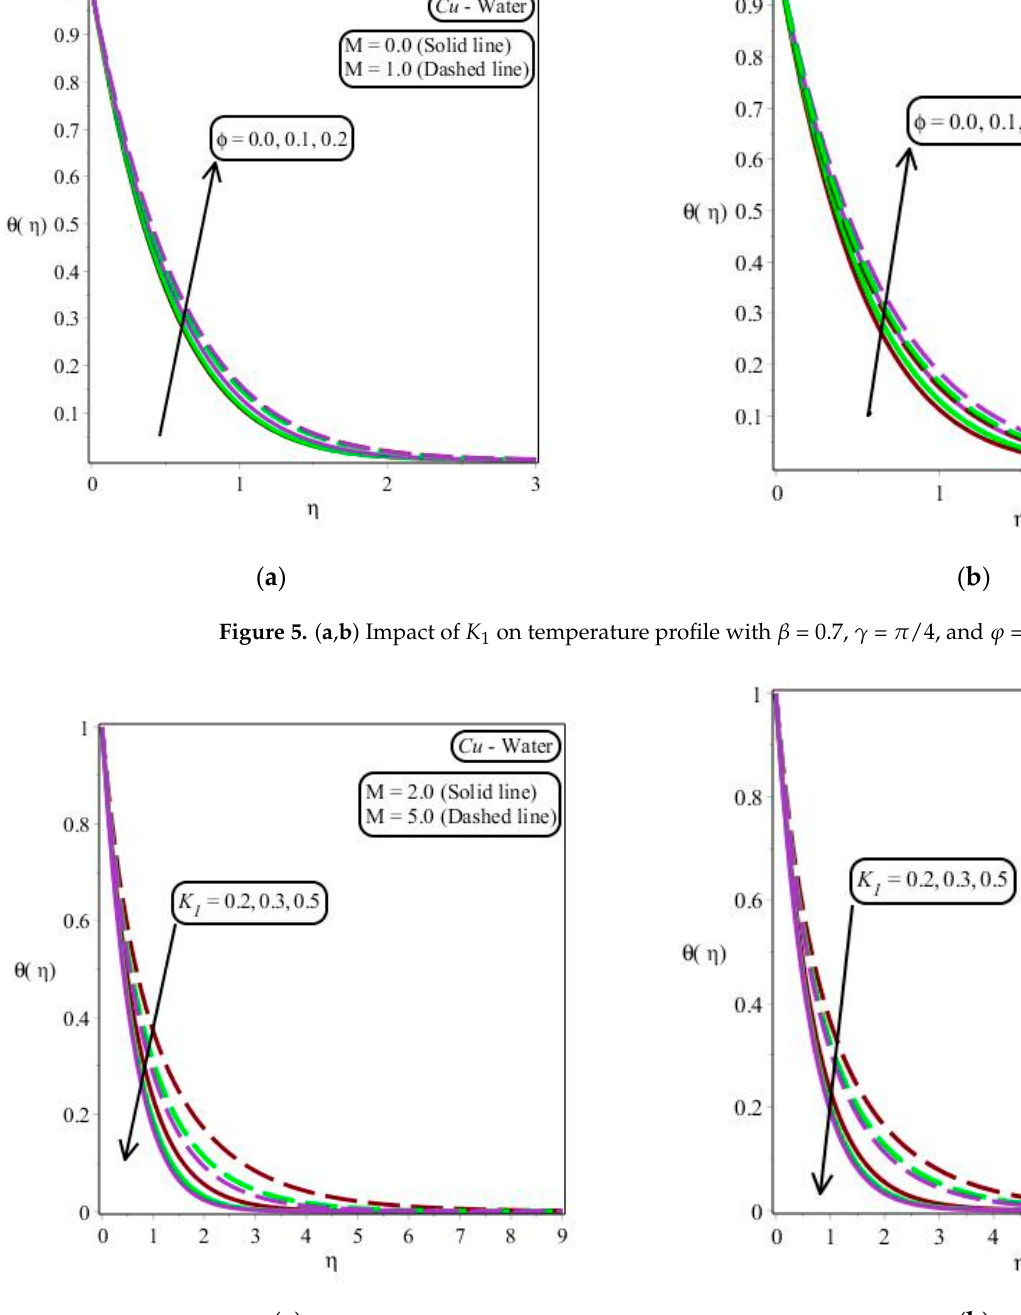
Figure 6. ( a , b ) Impact of β on temperature profile with K 1 = 0.7, γ = 𝜋/4 , and M = 0.2.